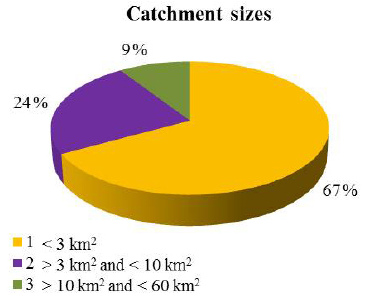
Figure 4. Distribution of flash flood events in the different catch- ment size classes: (1) <3km 2 ; (2) >3 and <10km 2 ; (3) >10 and <60km 2